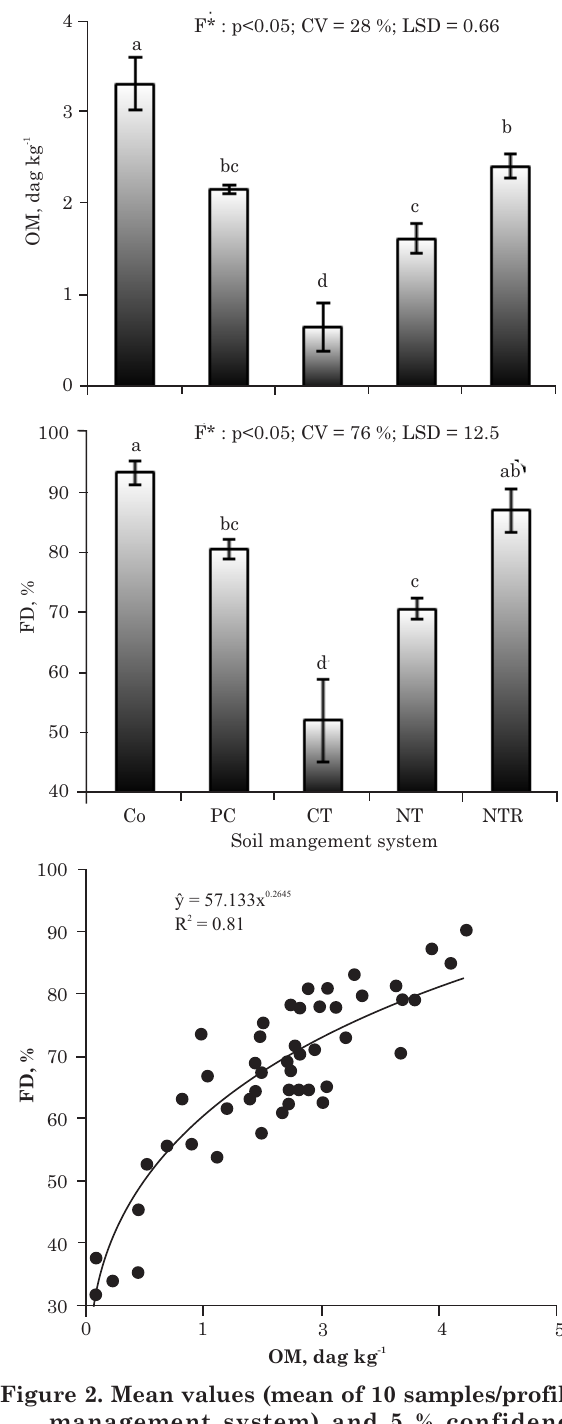
Figure 2. Mean values (mean of 10 samples/profile/ management system) and 5 % confidence intervals for organic matter (OM) (a) and the flocculation degree (FD) (b) of a Red Latosol with native forest (Co-control) and with different management systems (PC: perennial crop, CT: conventional tillage; NT: no-tillage without crop rotation; NTR: no-tillage crop rotation) and the relationships between the OM and FD values (c). Means followed by the same uppercase letter do not differ according to the Tukey’s test at 5